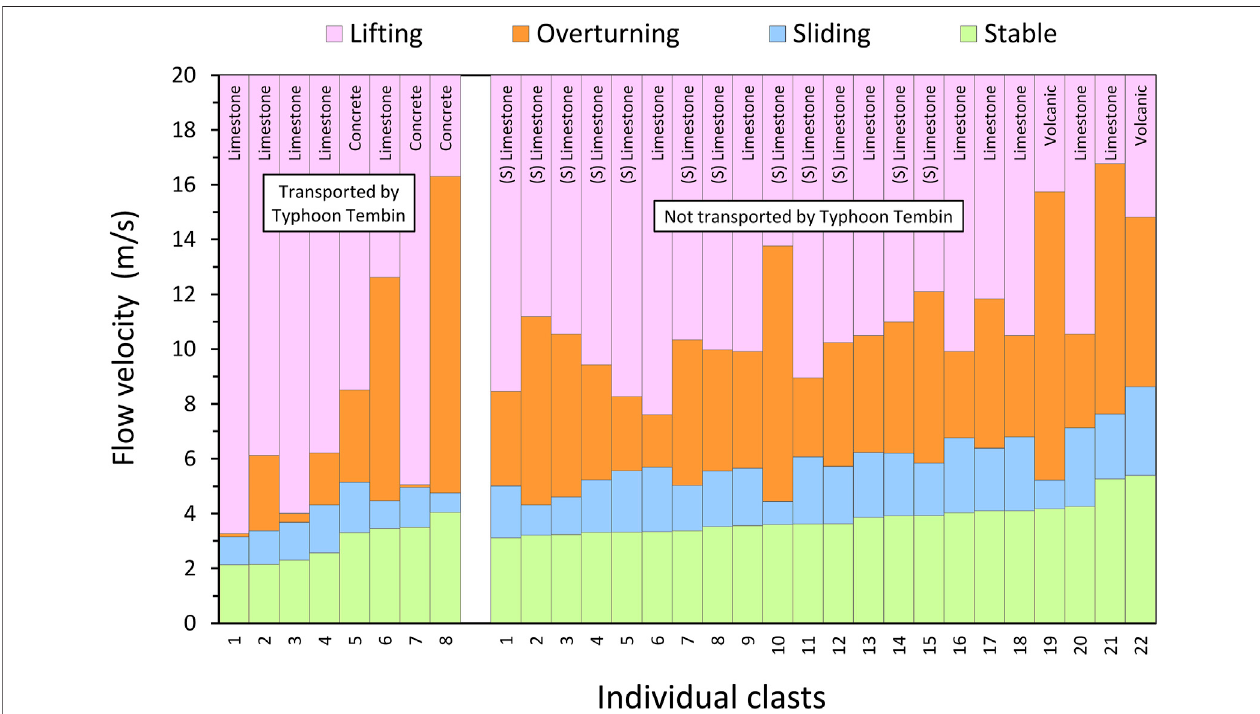
FIGURE 12 | Transport histogram for coastal boulders at the Dahu Reef study site. Only those clasts for which past wave-transport is certain are included. The horizontalaxisarrangesindividualclastsinascendingrankaccordingtothe fl owvelocityneededbeforestabilitythresholds(greenshading)areexceeded,soallowingthe initiation of transport. The left vertical axis displays the ranges of fl ow velocities capable of clast transport according to various transport modes (sliding, overturning, lifting),calculatedusingthehydrodynamic fl owtransportequationsofNandasenaetal.(2011);NandasenaandTanaka,(2013).Theminimum fl owvelocities(MFVs) requiredtosetbouldersinmotionarethevelocityvaluesatthebaseofeachcolourbandcorrespondingtothedifferentmodesoftransport.Itislikelythatoverturning( Eq. 4 ) was the transport mode necessary to move boulders from their source locations across the rugose and karsti fi ed surface of the Dahu Reef platform. Lifting ( Eq. 3 ) is assumed to have been necessary to stack together the limestone clasts forming the SBCs viewed in Figure 9 . Clasts exhibiting stacking (some with clear imbrication, see text) are identi fi ed by (S).